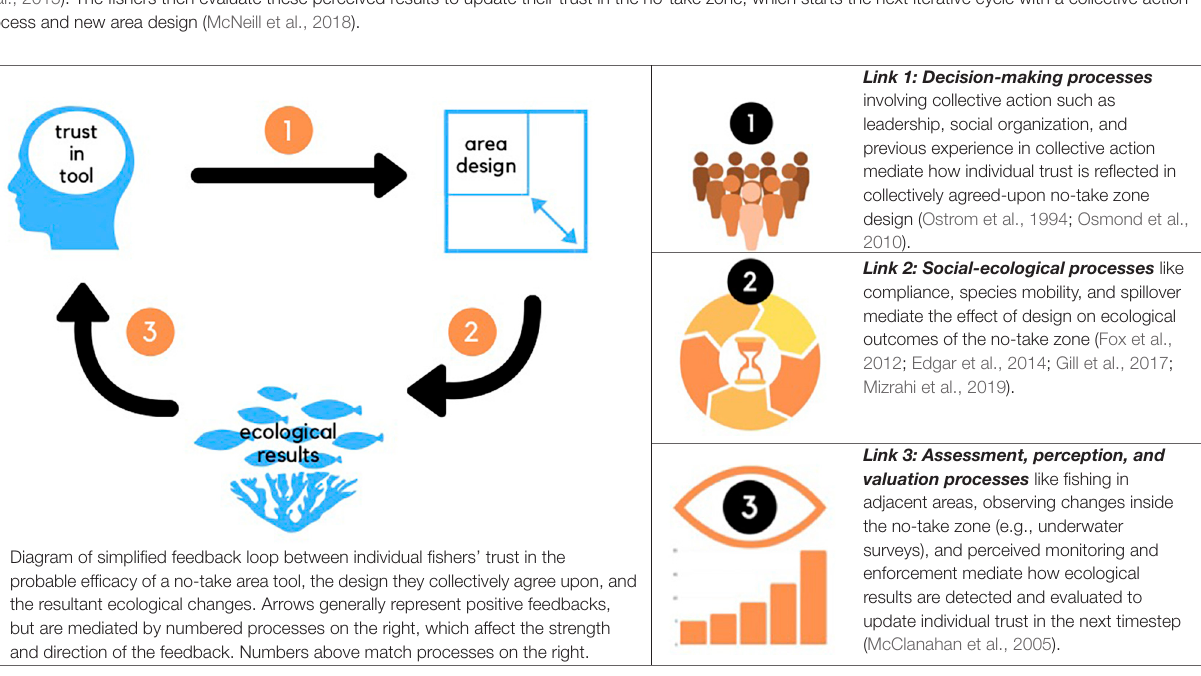
FIGURE 1 | A diagram of the simplified feedback loop and the three Links that make up the conceptual model. Model predictions: This simple model provides a potential mechanism for both an “upwards spiral” of increasing trust, improving design, and increasing ecological benefits, as well as a “downwards spiral” of evaporating trust, deteriorating design, and negligible ecological benefits. For example, the model predicts that when the system starts with low initial trust in the no-take zone’s potential, it leads to a low-risk design (e.g., small size or protection of unproductive sites) and thus insignificant ecological results. The lack of results further reduces trust in the no-take zone’s likely efficacy, which reduces fishers’ willingness to close productive areas, and further decreases the likelihood of ecological benefits (“downwards spiral”). Conversely, high initial trust leads to a better no-take zone design that produces significant and detectable ecological results, leading to greater trust in the no-take zone’s future potential. This leads to improving no-take zone design until the perceived costs (e.g., loss of fishing area) outweigh the benefits (“upwards spiral”). If such a feedback loop were to be widespread in adaptive no-take zones, the thresholds between these two outcomes in any particular context, as well as the mechanisms to reinforce or break out of the feedback loops, would be of great interest to conservation practitioners as well as